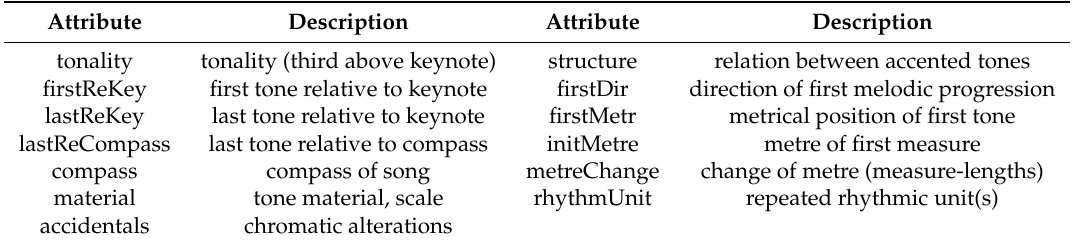
Table 2. Music content attributes included in this study, based on analyses by Frances